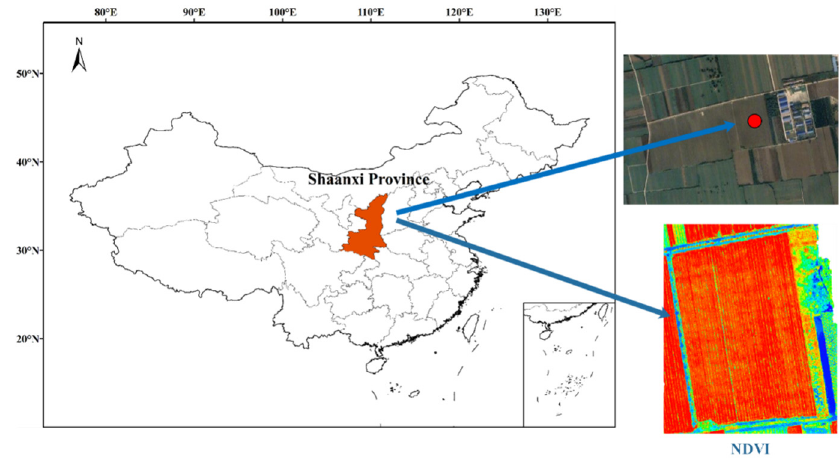
Figure 1. Location of the study region.